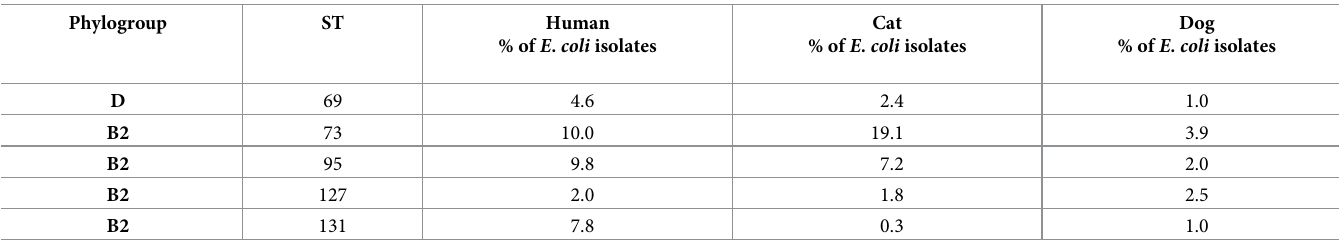
Table 6. Frequency with which STs 69, 73, 95, 127, and 131 are detected in cats, dogs and people living the in Canberra, ACT region of Australia.